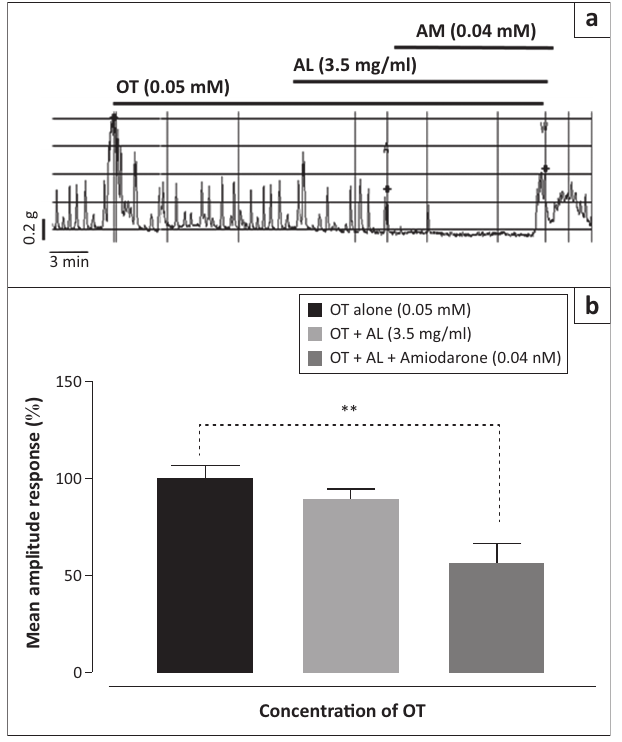
FIGURE 6: Effect of Alchornea laxiflora (AL) in the presence of amiodarone, a K + -channel blocker. Figure a represents original recording of the effect of AL on oxytocin (OT)-induced (0.05 mM) uterine contraction in the absence and presence of amiodarone (0.04 mM). Figure b represents bar plot analysis of the response of OT to AL in the absence and presence of amiodarone. Significant inhibition ( p < 0.01) of OT by AL in the presence of amiodarone was observed. n = 4 animals; ** p < 0.01; AM = amiodarone.